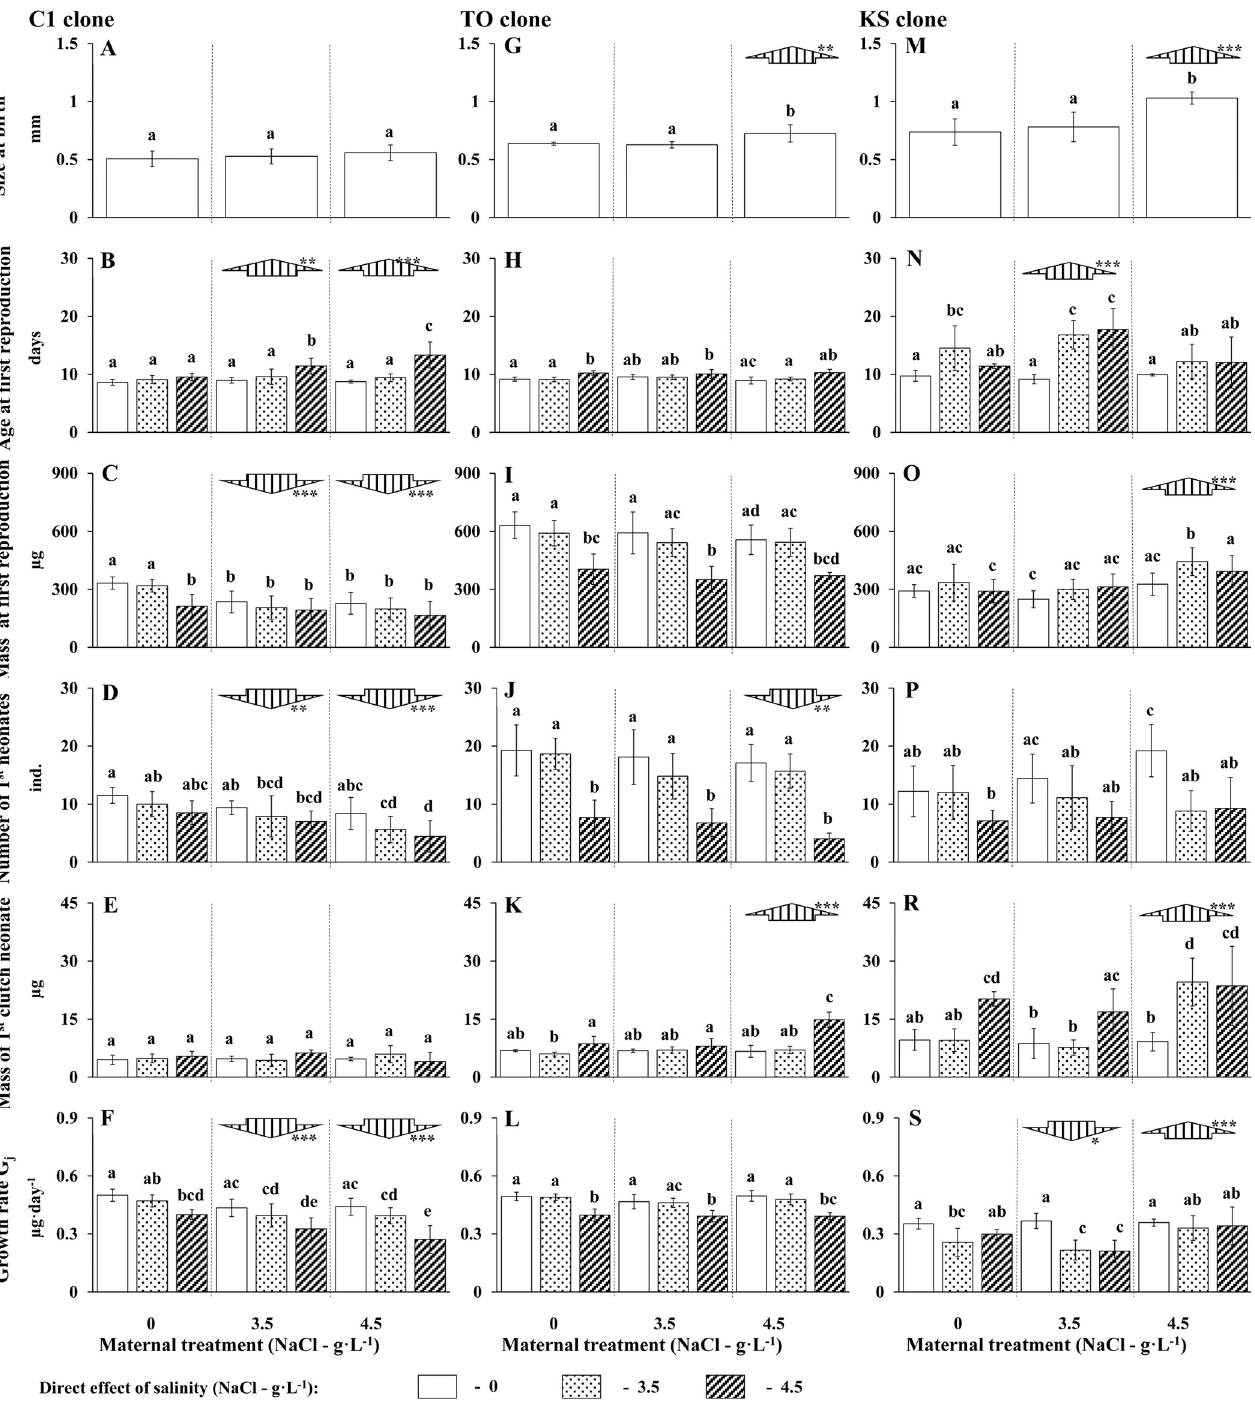
Fig 2. Direct and indirect (via maternal effect) effects of NaCl on life history parameters of Daphnia magna from three clones (averages ± 1 SD); large arrows and their directions indicate significant differences compared to animals born from females not exposed to increased salinity, post-hoc Tukey test calculated only for maternal effect ( * —p < 0.05, ** —p < 0.01, *** —p < 0.001); small letters indicate homogenous groups, post-hoc Tukey test for different N (Spjotvoll-Stolone test), p < 0.05.